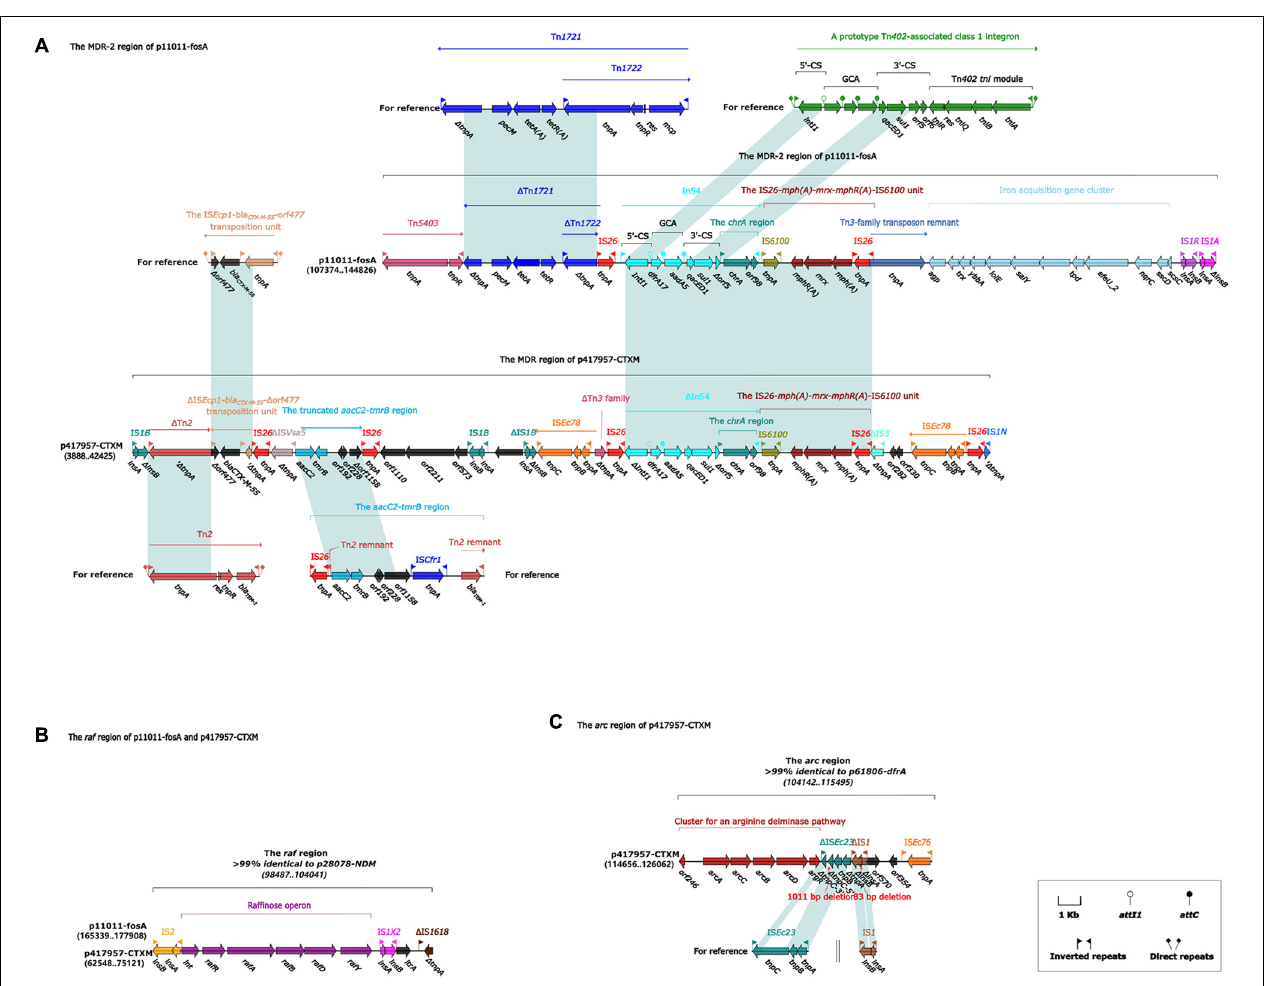
FIGURE 4 | (A) The MDR-1 region of p11011-fosA and MDR region of p417957-CTXM. (B) The raf region of p110011- fosA and p417957-CTXM. (C) The arc region of p417957-CTXM. Genes are indicated by arrows. Genes, mobile elements, and other features are colored based on functional classification. Shadows indicate nucleotide homology is greater than 95%. The number in parentheses indicates the location of the fragment in the